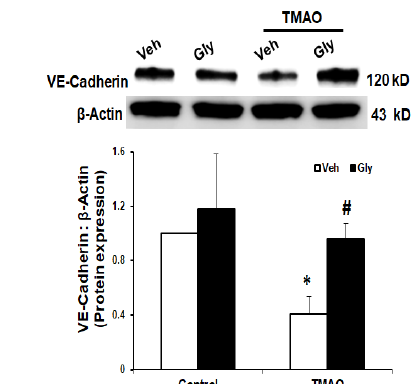
Figure 3. Effects of HMGB1 binder glycyrrhizin on TMAO-induced tight junction proteins ZO-2, Occludin, and VE-Cadherin in EOMAs. Representative Western blot ( n = 3–5) images show the ZO-2 ( A ), Occludin ( B ), and VE-Cadherin ( C ) expression in EOMAs with or without stimulation of TMAO and / or HMGB1 inhibition by glycyrrhizin. Veh: vehicle. * significant difference from control, # significant difference from TMAO.